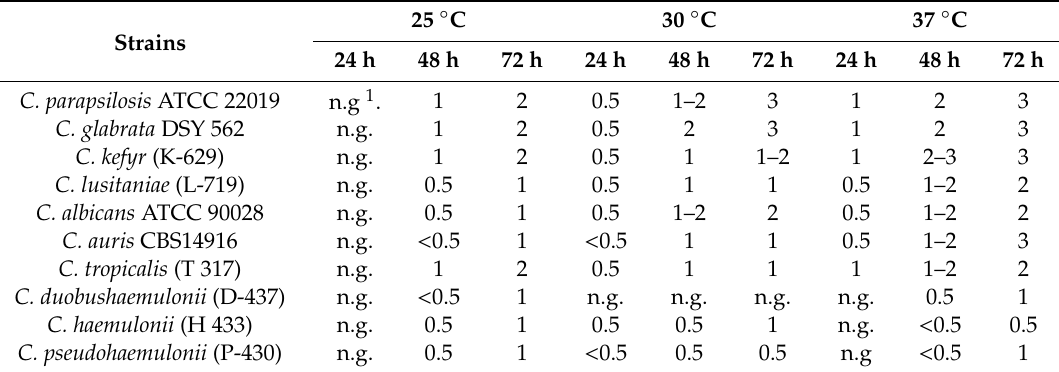
Table 3. Average of colony size of Candida species grown at di ff erent temperatures.